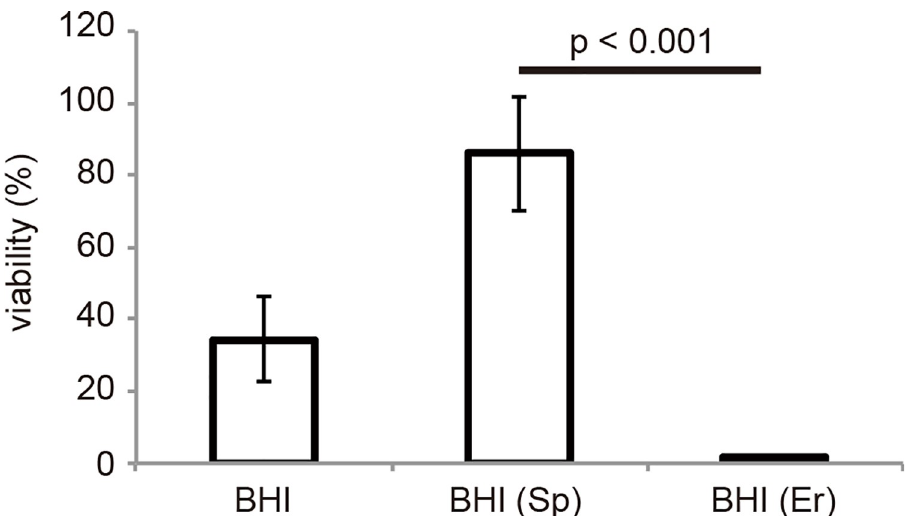
Fig 5. Survival of Streptococcus gordonii in human PMNs. For bactericidal assays, we prepared Streptococcus gordonii DL1 harboring a plasmid that conferred spectinomycin (Sp) resistance and S . gordonii SK12 harboring a plasmid that conferred erythromycin (Er) resistance. Human PMNs (1 × 10 6 cells) were incubated with bacteria (4 × 10 6 cells; 1:1 mixture of S . gordonii DL1 and SK12) for 2 h at 37˚C on a rotator. The PMN/bacteria mixture was disrupted with sterile water and plated on BHI agar plates supplemented with or without Sp or Er to enumerate live bacteria. Percent survival was calculated based on the number of colony forming units of bacteria mixed with PMNs compared to that of bacteria alone. n = 4; mean with standard error is shown. Statistical differences in the means of obtained values were evaluated via unpaired t -test.